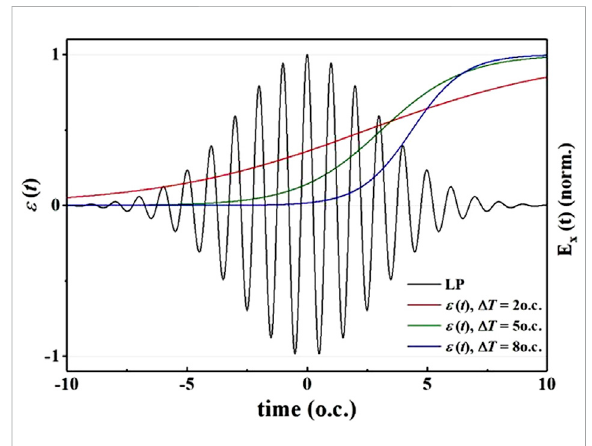
FIGURE 6 Variation of ellipsometry in laser fi eld with different time delays. The solid black line shows the time-dependent electric fi eld of the linearly polarized laser in the x-direction. The red, green, and blue lines show the ellipticity versus time curves for delay times Δ T = 2 o.c., 5 o.c., and 8 o.c.,